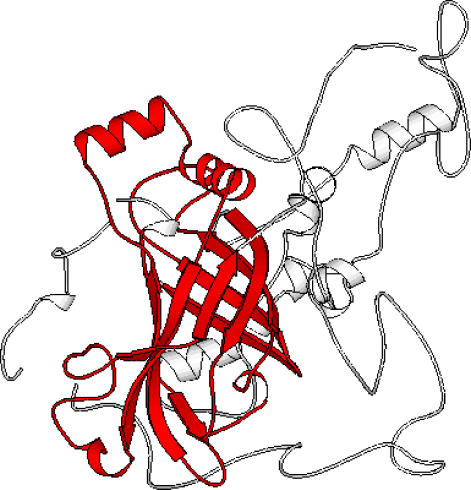
Superposition of the Catalase HPII (PDB 1iph; First Domain of Chain A) as It Is Classified in the CATH Database and Its Match to Bovine Beta-Lactoglobulin, Coloured Red, (PDB 1beb; Chain A), the Closest Relative Identified by CATHEDRAL